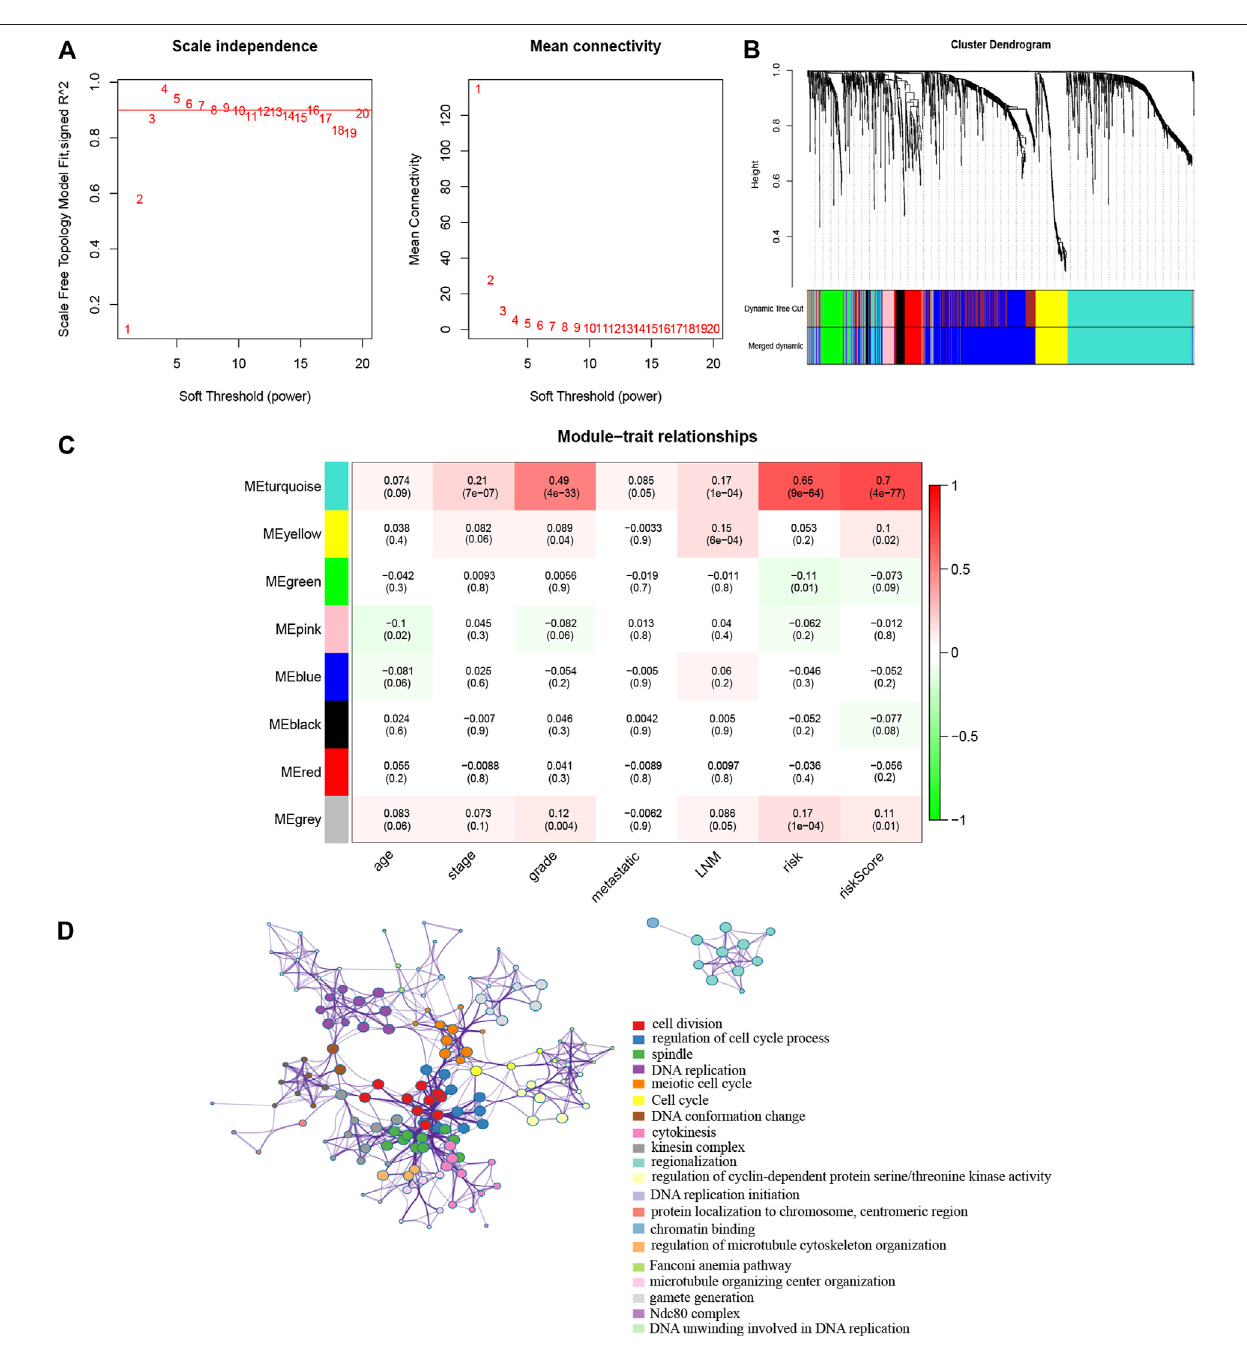
FIGURE 7 | WGCNA was performed to identify the potential mechanisms associated with the prognostic signature (A) . Screening of the soft threshold (B) . Clustering dendrogram of genes in EC tissues (C) . Correlation analysis of gene modules with risk model and clinical traits (D) . Enrichment clustering network analysis in the Metascape